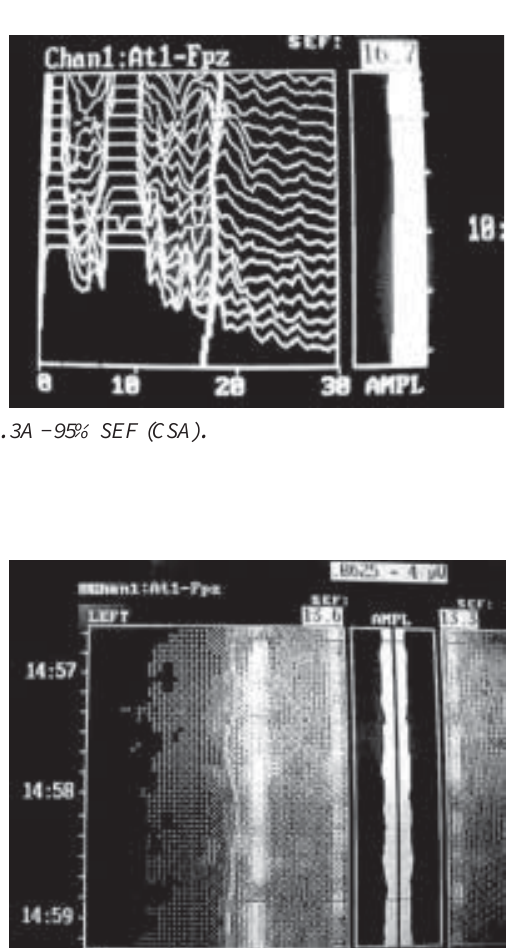
Fig. 2 - Types of EEG waves according to the frequency